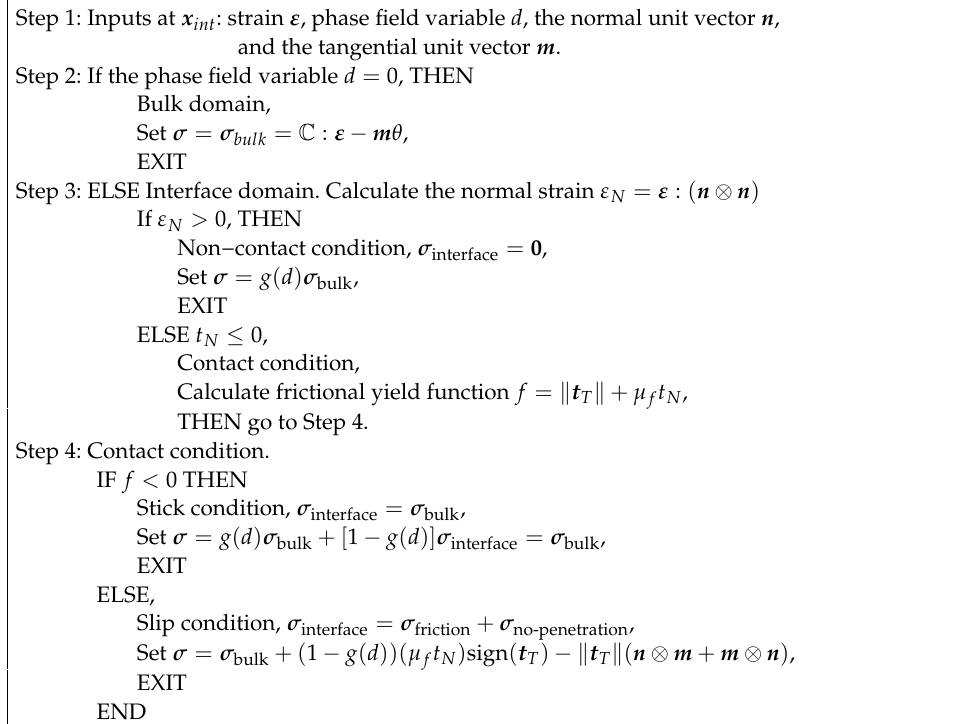
Box 1 . Stress update algorithm for phase field modeling of the frictional contact